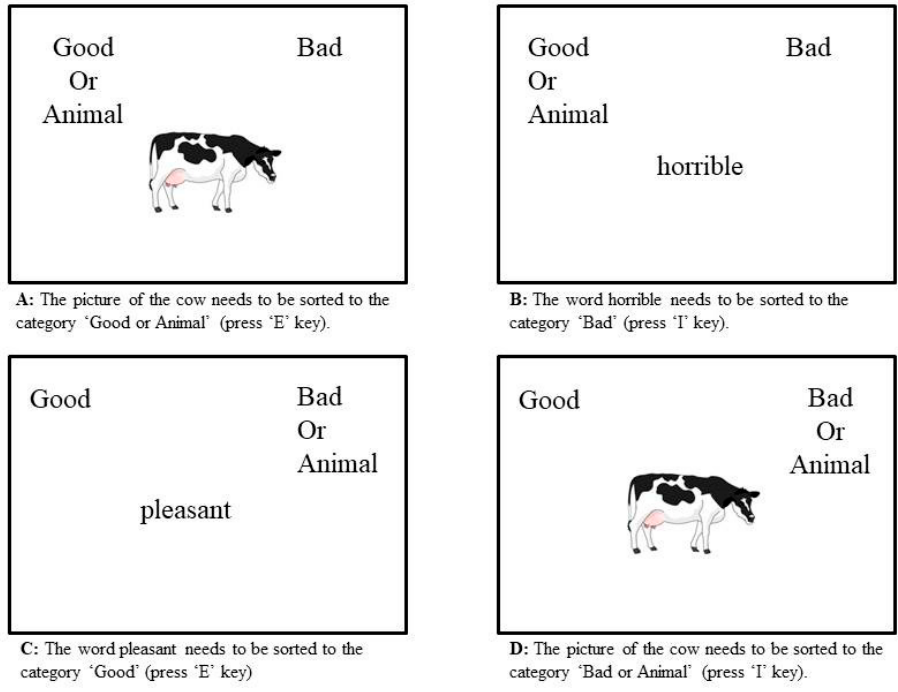
Figure 1. Examples from the IAT representing possible evaluation tasks.